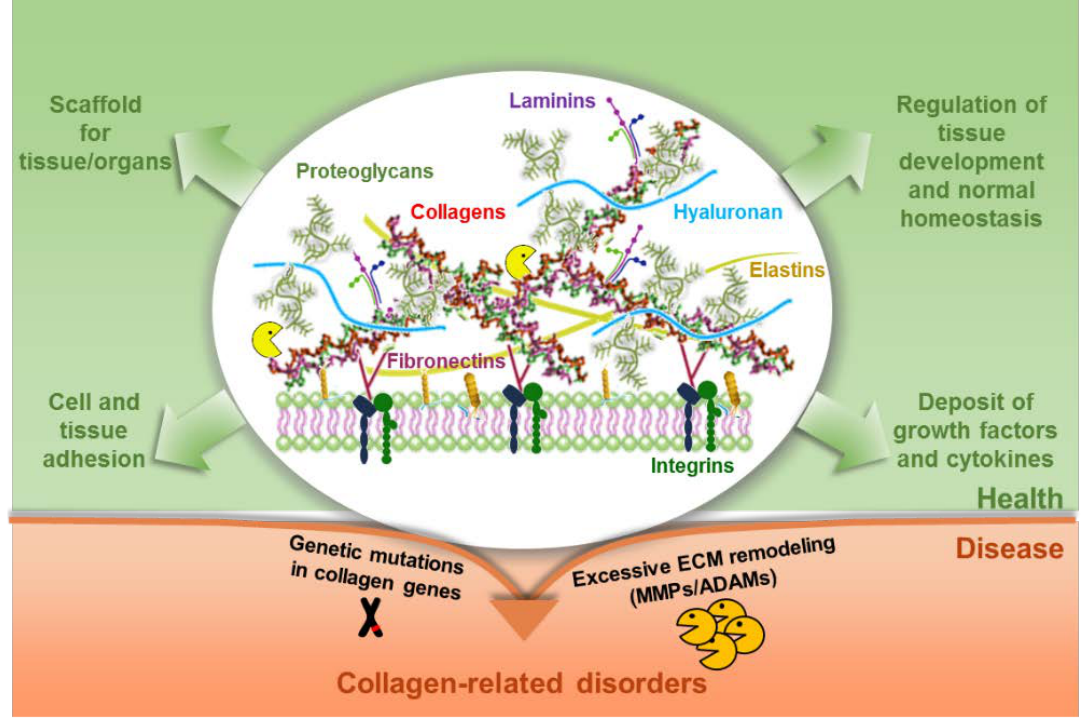
Figure 1. Schematic representation of the complex meshwork of proteins forming the extracellular matrix (ECM). The main ECM components, namely collagens, proteoglycans, hyaluronan, fibronectin, laminin and elastin, as well as the integrin ECM receptors, are depicted. The ECM provides mechanical support and anchoring for cells and tissues but it also acts as a reservoir of growth factors and cytokines and regulator of normal tissue development and homeostasis. Alterations in any of these functions result in a pathological status characterized by various tissue abnormalities.